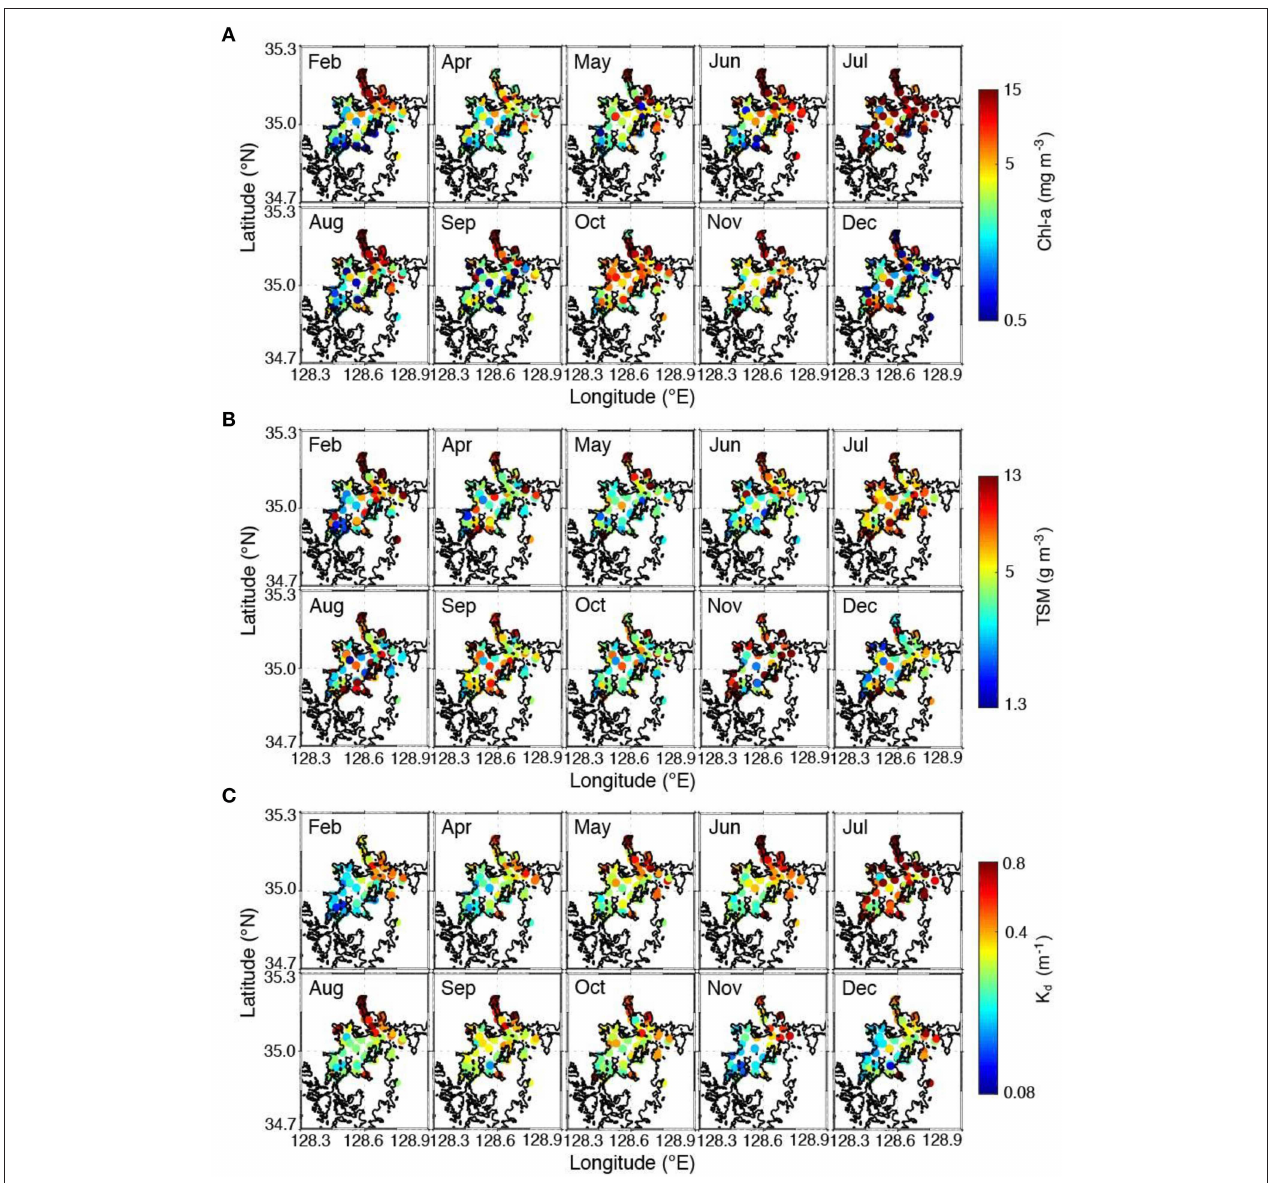
FIGURE 3 | Monthly spatial distribution of (A) in situ Chl-a (mg m − 3 ), (B) in situ TSM (g m − 3 ), and (C) in situ K d (m − 1 ).